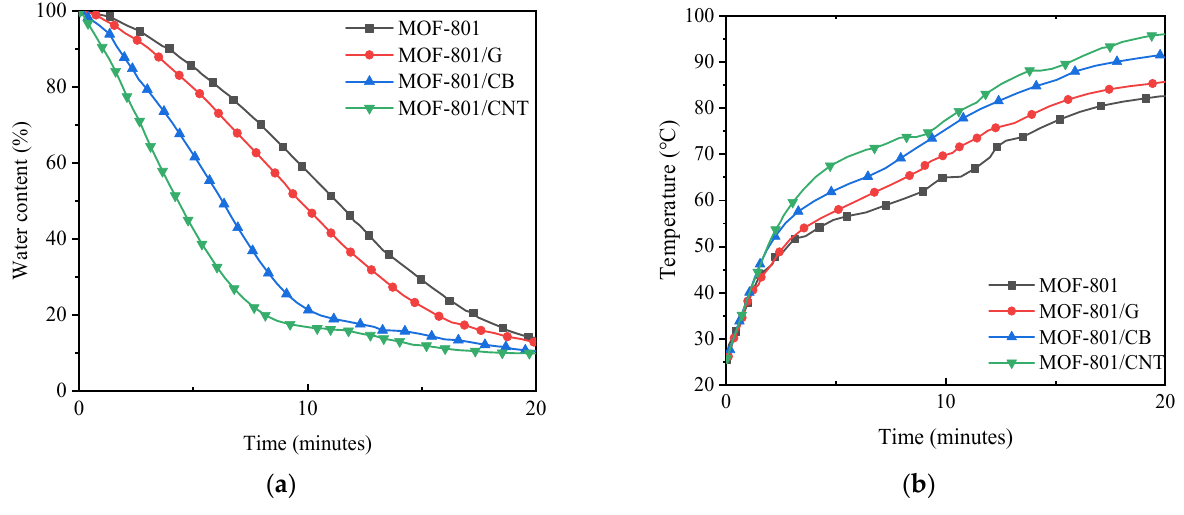
Figure 9. Water content and temperature change profiles of four adsorbents irradiated under 1 kW/m 2 simulated sunlight. ( a ) Desorption curves of four adsorbents under one sun illumination. ( b ) Internal temperature of four adsorbents during desorption.